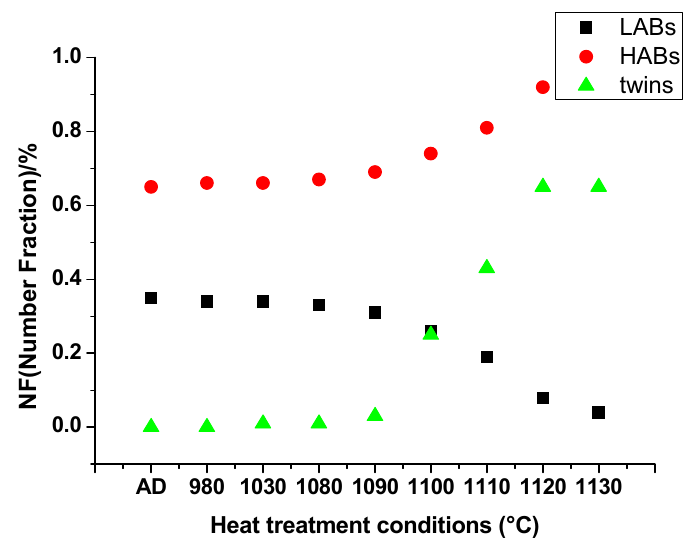
Figure 6. Grain boundary distributions of as-deposited condition and di ff erent solution heat treatment conditions.